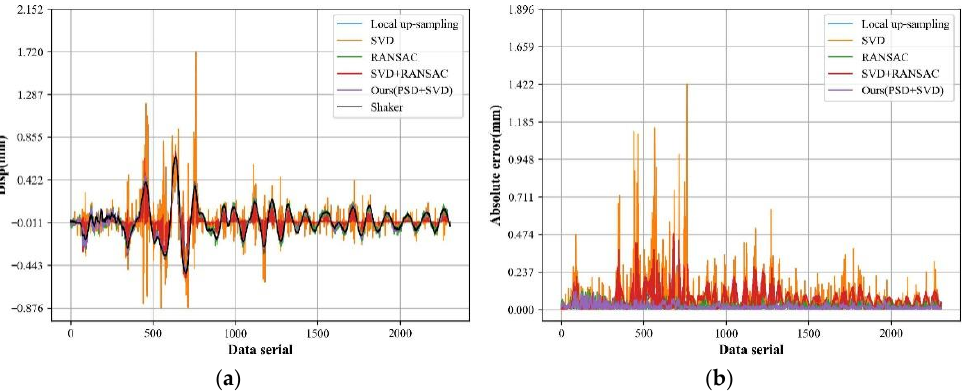
Figure 14. The experimental results of the high-speed railway multi-functional shaking-table test system; where ( a ) is the displacement sequence calculated by each phase correlation method and the input displacement sequence of the shaking table, ( b ) is the absolute error of the displacement sequence of each phase correlation method. Table 4. Average absolute error of each phase correlation method, where the bold font is the mini- mum error value among the five methods.